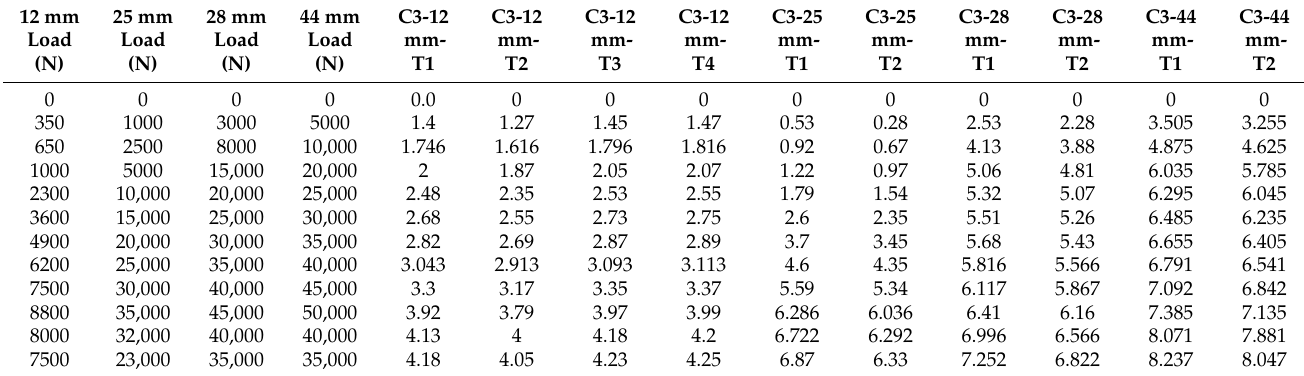
Table A3. Peak force and associated displacement for punch test cell 3 (C3).